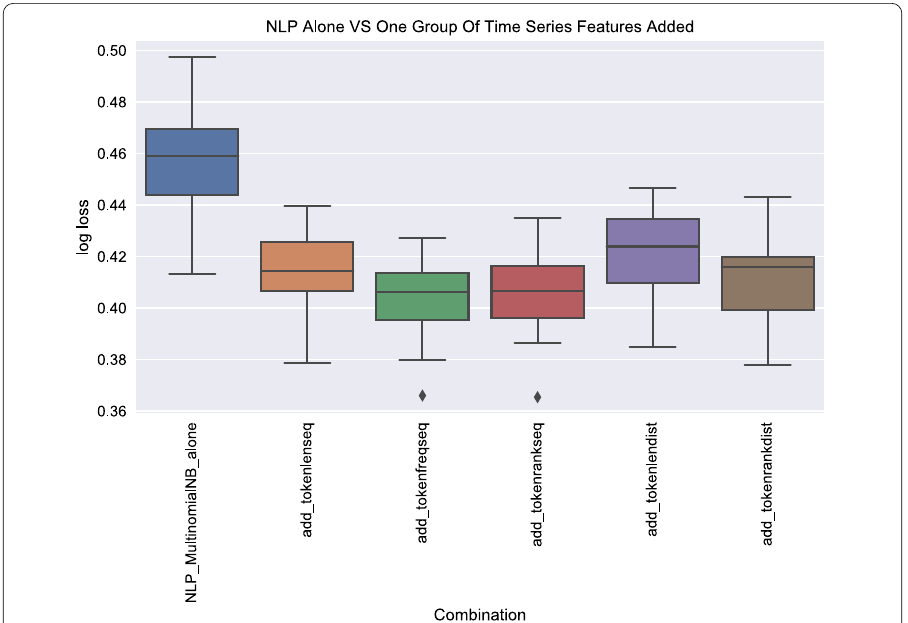
Figure 8 Box plots of the evaluation results for NLP predictions (Multinomial NB) alone and with one extra time series features group